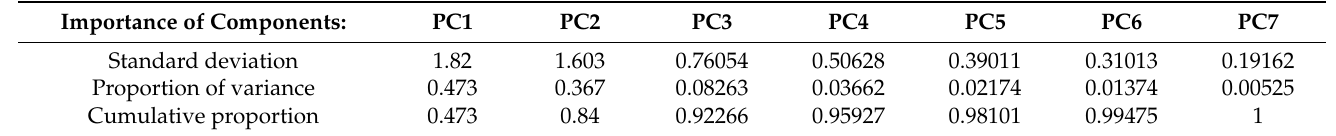
Table 1. Total variance of the cumulative data gathered throughout the experiment explained by principal components.